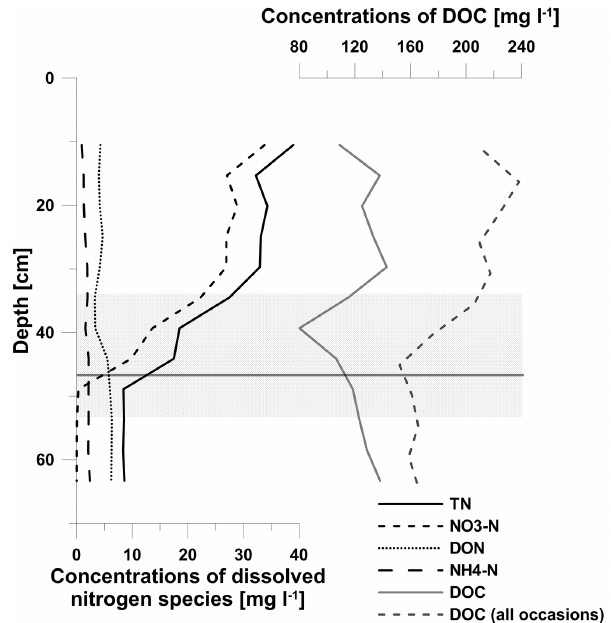
Fig. 6. Vertical profiles of total nitrogen (TN), dissolved organic nitrogen (DON), NO 3 –N, NH 4 –N and dissolved organic carbon (DOC) concentrations after cattle slurry application in April 2012. DOC (all occasions) represent the mean vertical DOC concentra- tions during periods without slurry application. The horizontal line represents the mean water table position and the dotted area repre- sents the amplitude of the water table fluctuation during the sam- pling